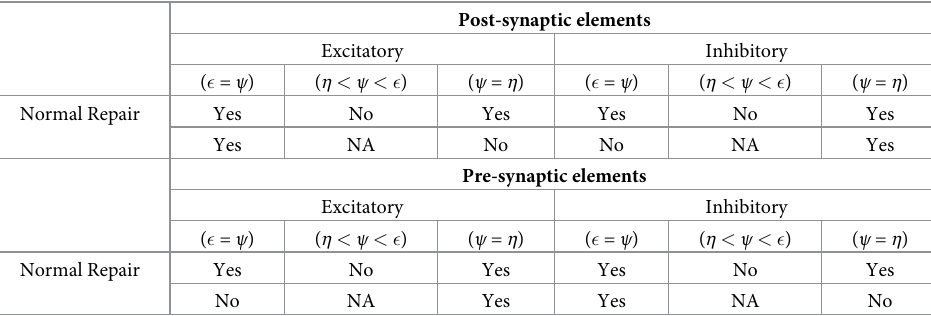
Figs 6 and 7 show the course of rewiring of excitatory and inhibitory connections to excit- atory neurons in the centre of the LPZ from simulations using growth curves satisfying the derived constraints. As described in experimental studies, the loss of activity by neurons in the LPZ is followed by an increase in excitatory input connections [13, 28] and a transient reduc- tion in inhibitory input connections [11]. Specifically, as also found in these experiments, the increase in excitatory inputs is dominated by an ingrowth of lateral projections from outside the LPZ. Both of these features can be seen in Fig 6A and 6B. As shown in Figs 8 and 9, neu- rons directly outside the LPZ lose excitatory and gain inhibitory input connections to reduce their activity back to their optimal values. These figures also show that, in line with experimen- tal observations, there is an increase in the number of inhibitory synapses these neurons receive from the LPZ. Finally, even though the much larger number of inhibitory neurons out- side the LPZ do increase their inhibitory projections on to the network, Figs 7C and 9C con- firm that the strongest inhibitory projections are received from the LPZ.